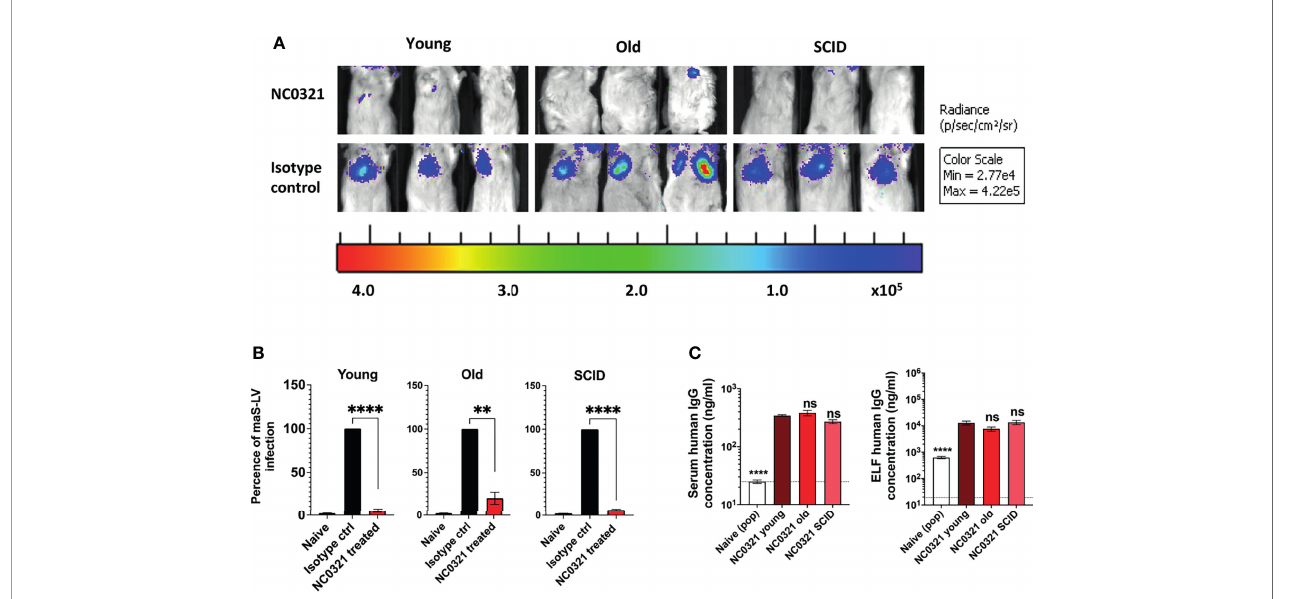
FIGURE 3 | rSIV.F/HN mediated NC0321 mAb expression in young, old, and SCID mice against maS-LV infection. (A) Bioluminescence imaging of young (5-9 weeks weeks), old (7-8 months weeks), and SCID mice (6 months weeks) dosed with 5E8 TU rSIV.F/HN-NC0321 or an rSIV.F/HN vector expressing an irrelevant isotype control mAb; at 21 dpi, mice were challenged with 100 ng maS-LV-expressing luciferase. Imaging was performed 7 days post-maS-LV challenge. Representative images of n = 4 – 8/group are shown. (B) The bioluminescent value (photons/s/cm 2 /sr) for each animal in (A) was normalized such that the isotype control value was 100%. Naive values are from animals that did not receive maS-LV. Bars represent mean ± SEM ( t -test; ** represents p = 0.0095 and **** represents p < 0.0001, n = 4 – 8 per group). (C) The human IgG levels in sera and epithelial lining fl uid (ELF) in each group with NC0321 or isotype expressing vector transduction were determined. Human IgG levels in ELF were computed by comparison of urea levels in BALF and serum in every single sample (mean ± SEM, ordinary one-way ANOVA. ns represents p > 0.05 and **** represents p < 0.0001). Naive value, without urea normalization, is indicated by the dotted